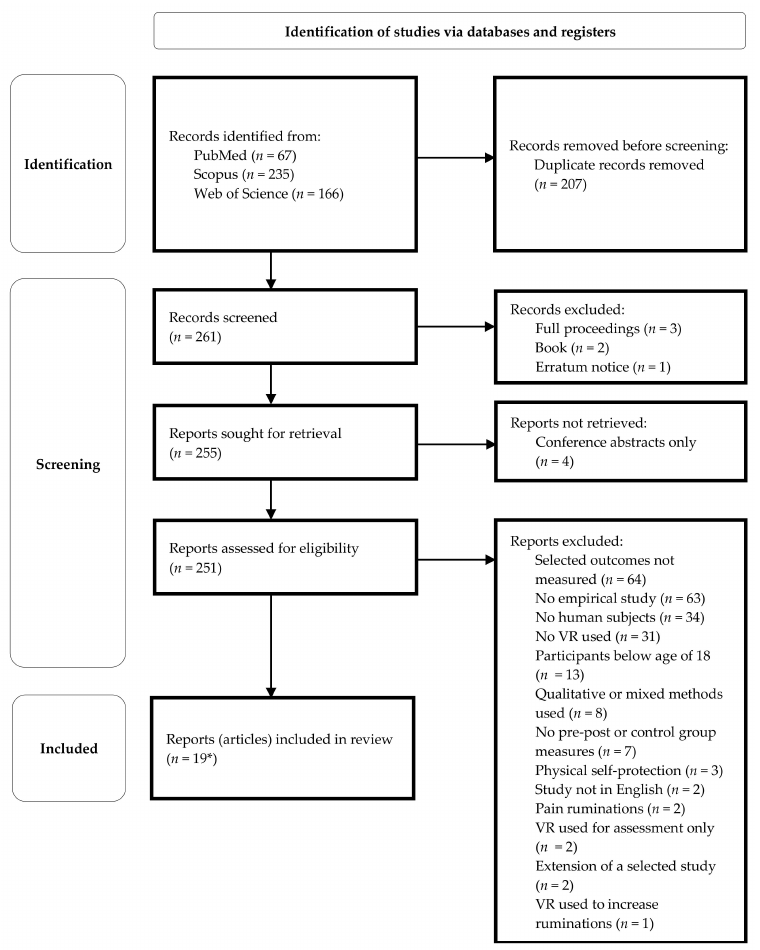
Figure 1. PRISMA 2020 flow diagram of selected reports. * Two articles on the final list had been identified as reports of the same research; therefore, the final number of selected reports is